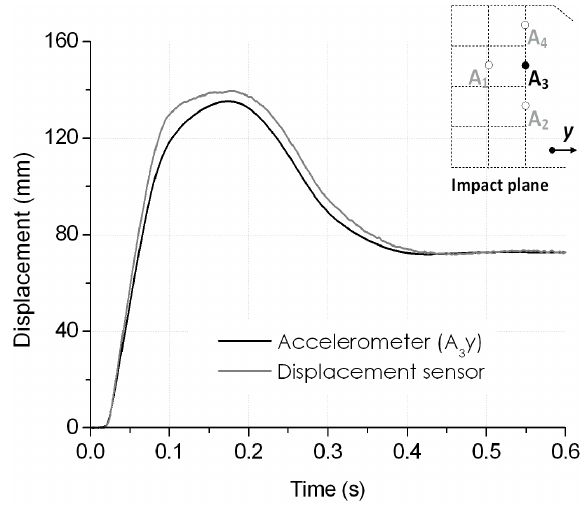
Figure 6. Comparison of the different penetration estimates (210kJ impact test). Figure 7. Comparison of the horizontal displacement 3.5m from